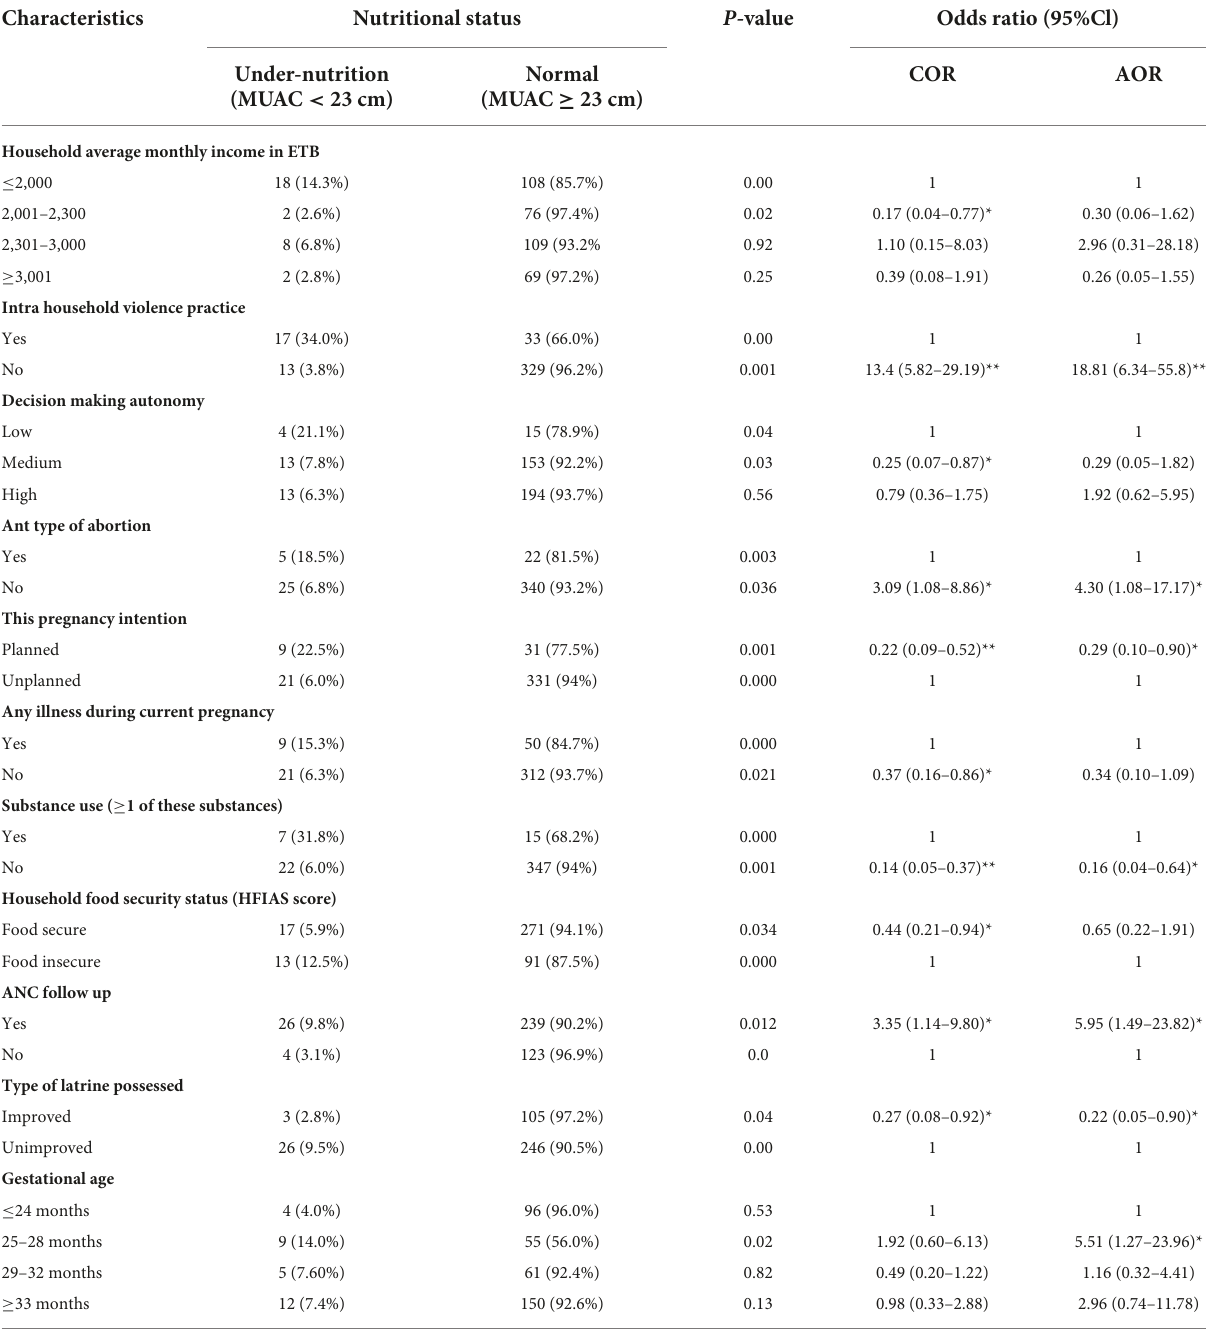
TABLE 6 Multivariate analysis test for nutritional status of pregnant women.